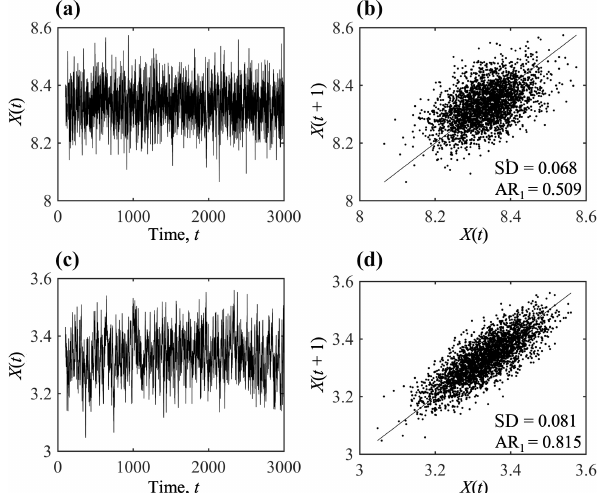
Figure 1. Characteristic changes in the system of a harvested pop- ulation when approaching the critical transition: (a) population dy- namics and (b) statistical metrics when the system is far from tip- ping ( E = 0 . 1); (c) population dynamics and (d) statistical metrics when the system is closer to tipping ( E = 0 . 4). Note that the spin-up periods are